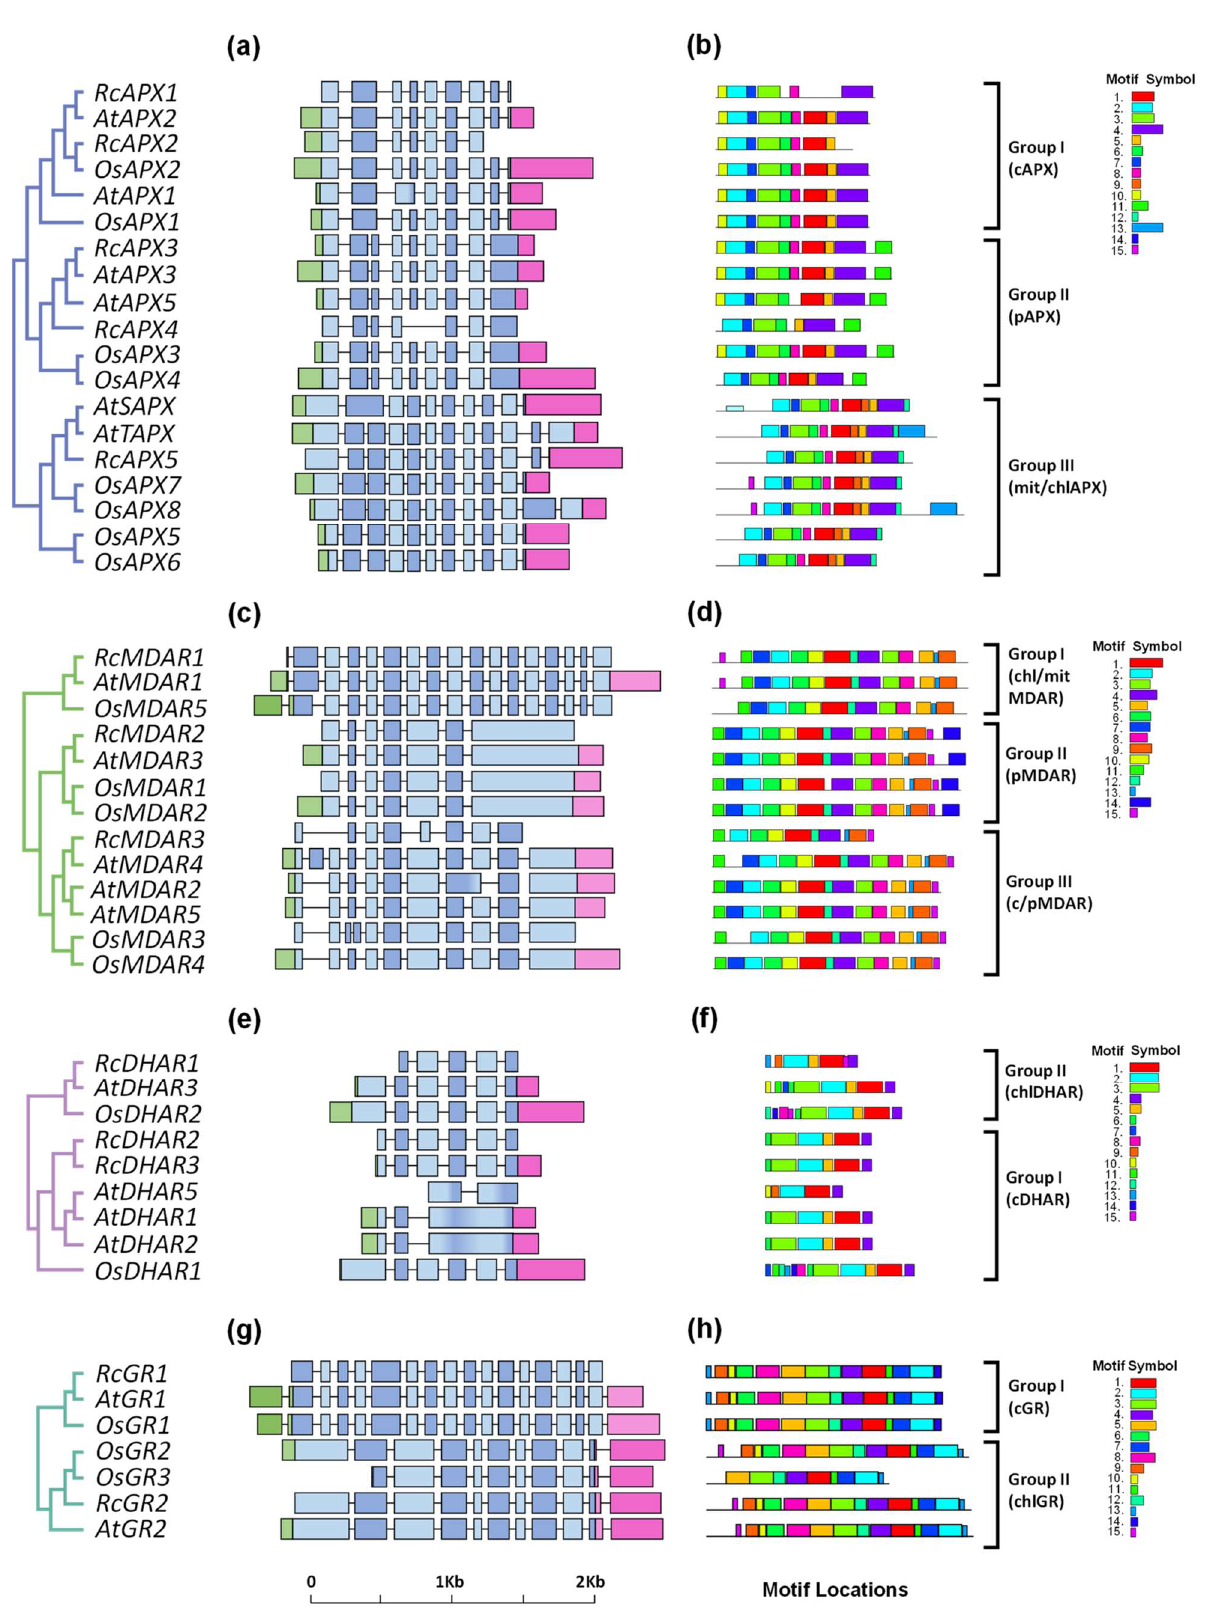
Figure 3. Exon-intron structure and conserved motifs analyses of APX, MDAR, DHAR, and GR families in Ricinus communis (Rc), Arabidopsis thaliana (At), and Oryza sativa (Os). ( a , e ) APX; ( b , f ) MDAR; ( c , g ) DHAR; and ( d , h ) GR. The phylogenetic relationships among analyzed proteins were